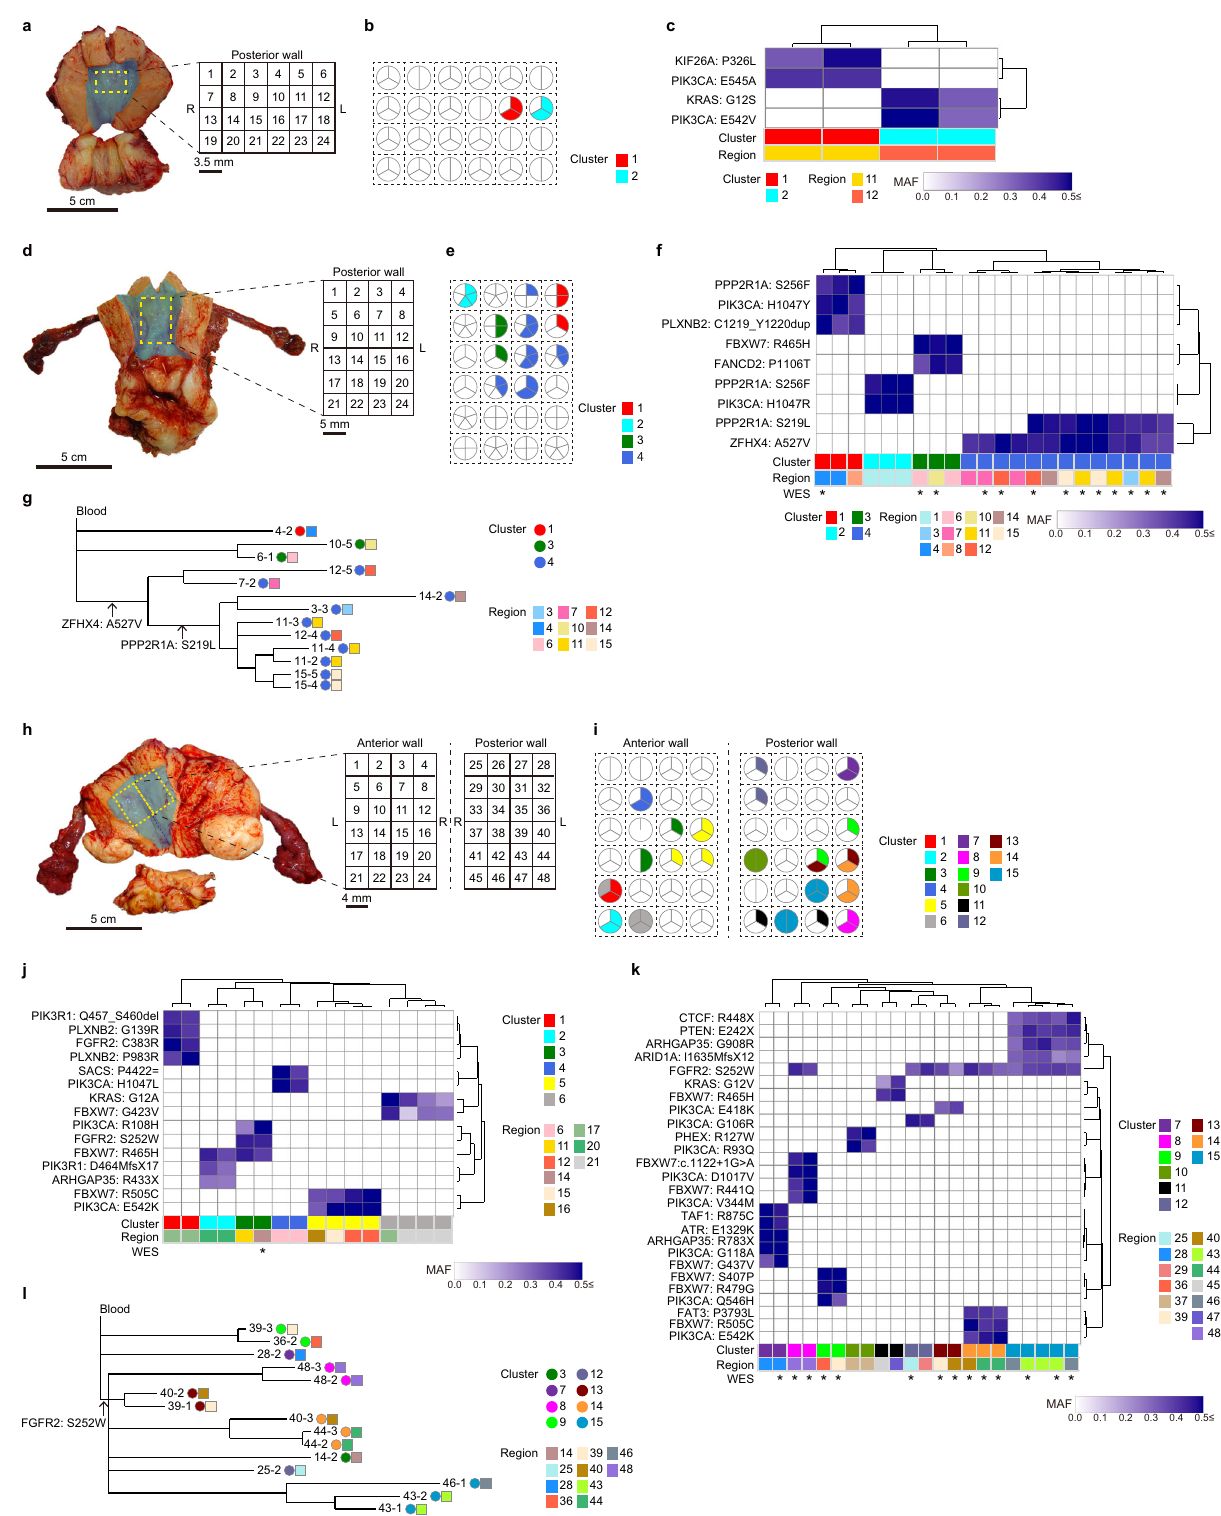
clones coexisted in subclonal states in the upper gland (G5) (Fig. 7g, h). Speci fi cally, the MAFs of mutations observed in either G3 or G4 were close to 0.5 in the corresponding glands but approximately 0.25 in G5 (Supplementary Fig. 10b). These results suggest that G3 and G4 independently rose from the rhizome (G1), and G5 was formed by the con fl uence of G3 and G4 on their way to the luminal side. NATURE COMMUNICATIONS| (2022) 13:943